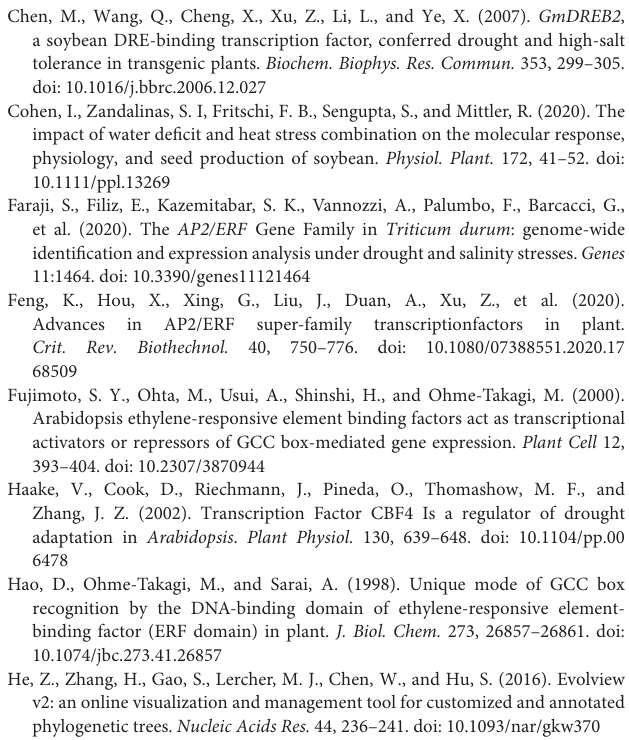
Supplementary Figure 1 | Phylogenetic relations, gene structures, and motif patterns of GmAP2/ERF members. Phylogenetic relations of the (A) AP2 subfamily, (B) ERF subfamily, (C) DREB subfamily, and (D) RAV subfamily. Orange boxes, blue boxes, and black lines indicate UTRs, exons, and introns, respectively. Bottom scales indicate exon and intron lengths. Supplementary Figure 2 | Cis-Element Analyses of Soybean GmAP2/ERF Genes. Therefore, the promoter region sequences (the 2-kp upstream sequences from gene initiation codons) of GmAP2/ERF genes were extracted for cis -element analyses. Cis -elements in the 2,000-bp upstream regions of soybean GmAP2/ERF genes were predicted using the PlantCare database, and colored boxes contain their names and positions (relative to the start codon). Supplementary Figure 3 | Salt-responsive differentially expressed genes and expression profiles of soybean GmAP2/ERF genes. Heat map with hierarchical cluster analysis of salt-responsive differentially expressed genes (DEGs) among soybean GmAP2/ERF genes. Different colors indicate relative transcript abundance of salt-responsive soybean GmAP2/ERF genes, with red indicating high abundance and green indicating low abundance. Supplementary Figure 4 | GmAP2/ERF144 protein structure analysis. Supplementary Figure 5 | Identification of GmAP2/ERF144 transgenic lines. (A) Cloning of GmAP2/ERF144 . (B) Quantitative real-time (RT)-PCR analysis of four independent transgenic soybean plants overexpressing GmAP2/ERF144 . (C) Herbicide screening transgenic lines. (D) The transgenic positive vaccine was detected by PCR. (E) Detection of overexpression soybean herbicide bar marker. Data represent the mean ± SE. ∗ , P < 0.05 (Student’s t -test). ∗∗ , P < 0.01 (Student’s t